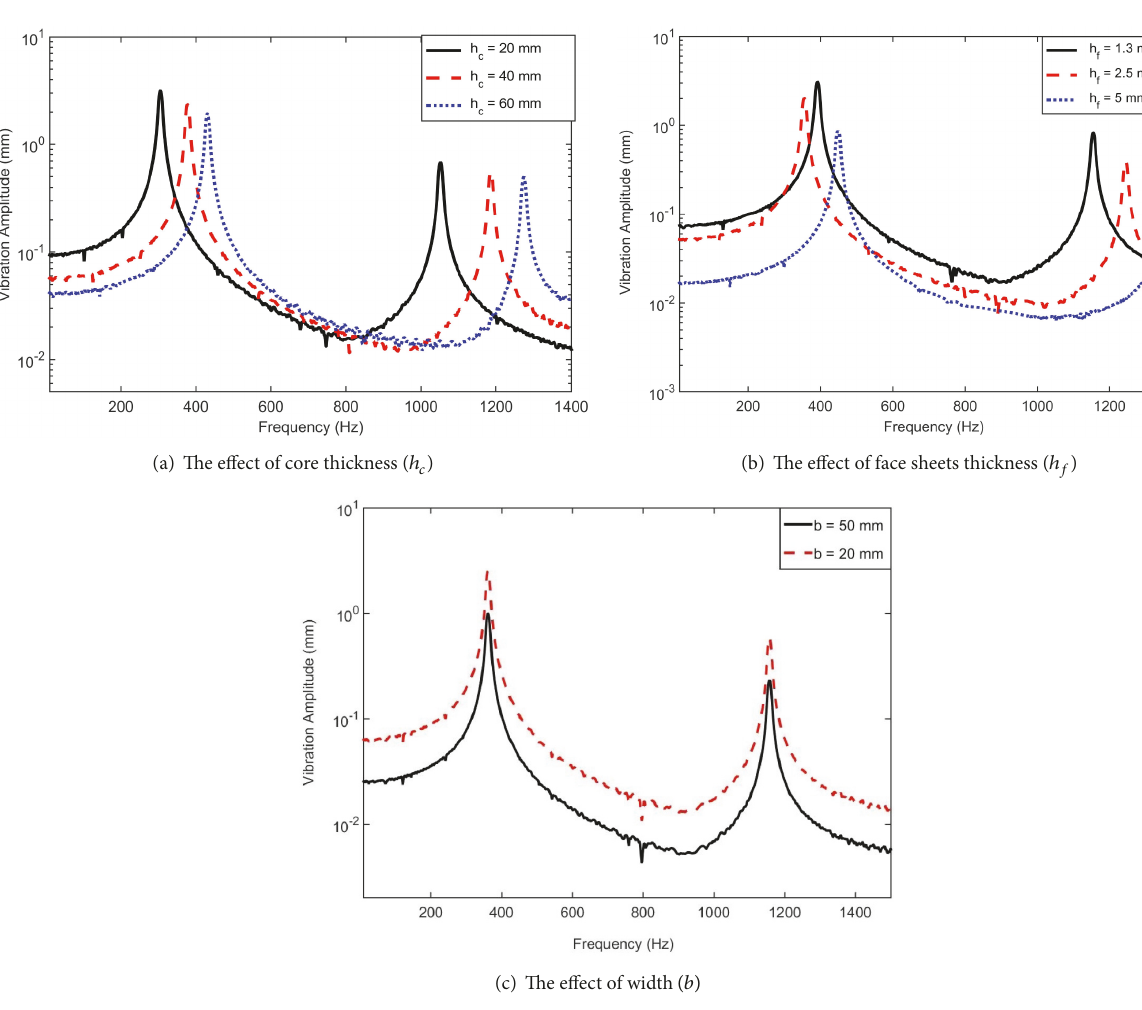
Figure 7: Vibration amplitude at the middle of the clamped-clamped edges sandwich beam with respect to applied frequency.